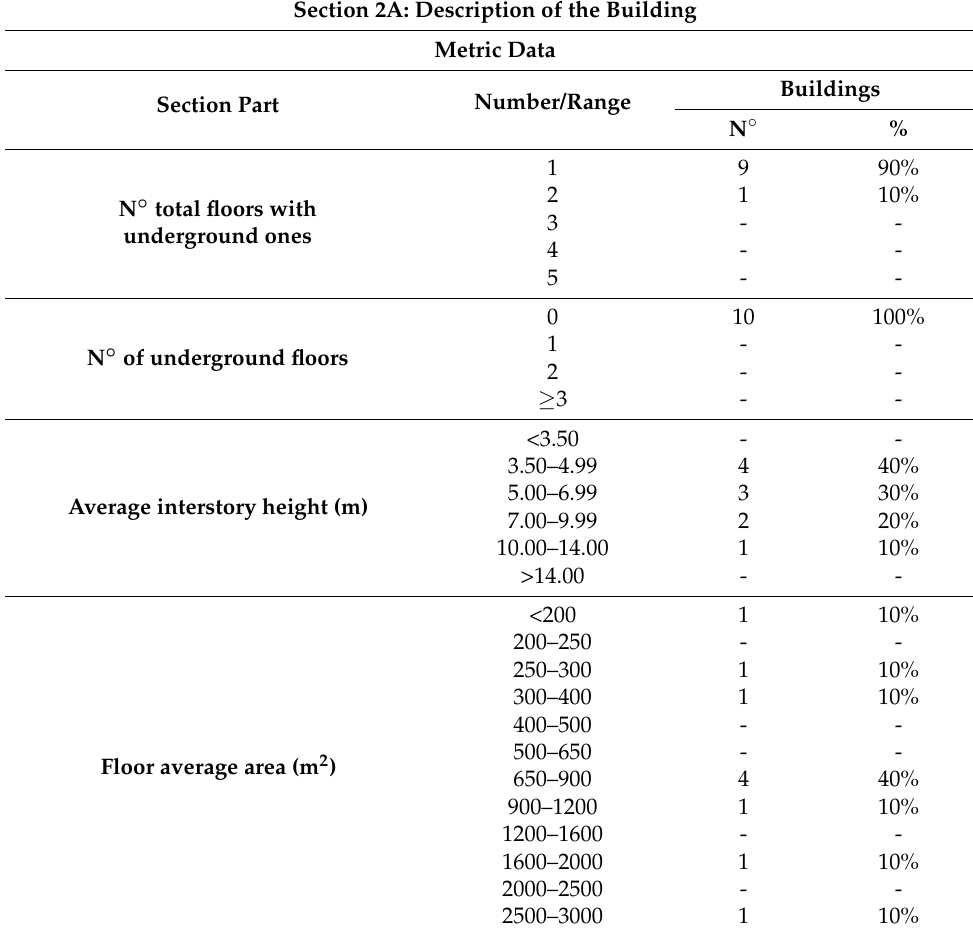
Table 8. Section 2 CARTIS-Building. Case studies characterization: Metric data—Synoptic panel.